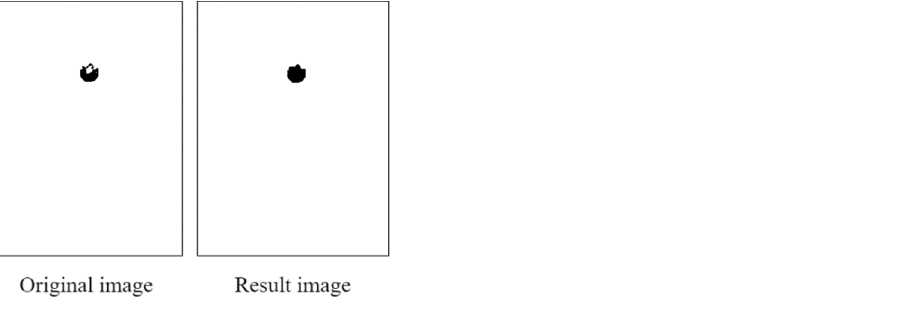
Figure 42. Image obtained with the PRSSM-based pupil diameter analysis module after the opening operation.